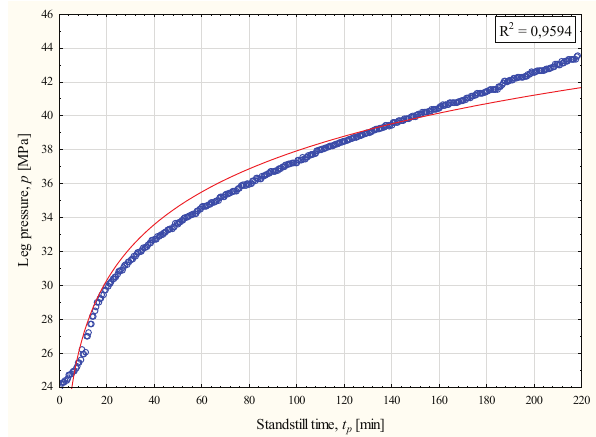
Figure 7: Correlating the real pressure increase in a leg with that predicted based on an exponential